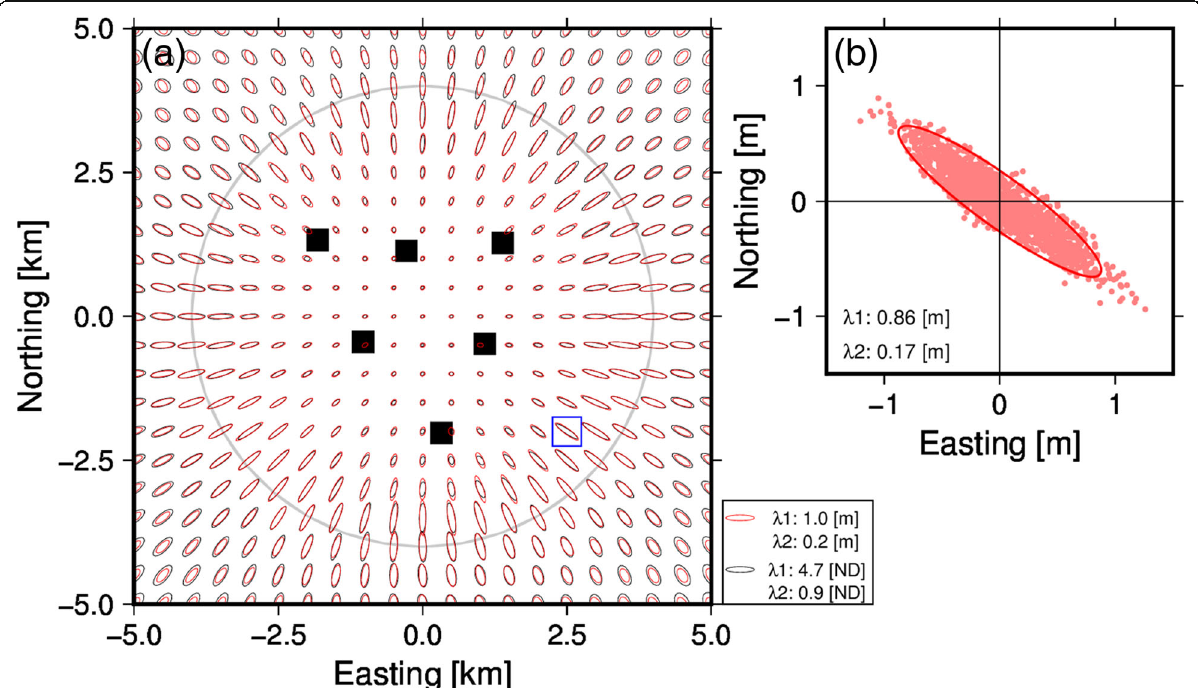
Fig. 8 Comparison of error ellipses (Fig. 7) with those calculated from synthetic testing. a The black ellipses are the same as those in Fig. 7. The red ellipses are 95% confidence ellipses calculated from array positions in a synthetic test. The gray circle is the range within which the sea surface platform exists using our mooring buoy system. b An example of array positions and the corresponding 95% confidence ellipse, calculated through 1000 repetitions of a synthetic test for the position (2.5 km, − 2.0 km) in Fig. 9a surrounded by a blue